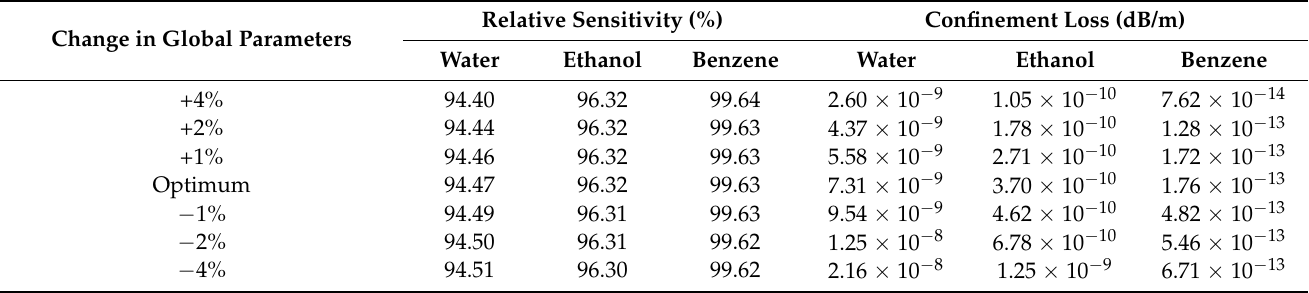
Table 1. Comparison among the variation in global parameters on optimum parameters at λ = 1.3 µm.